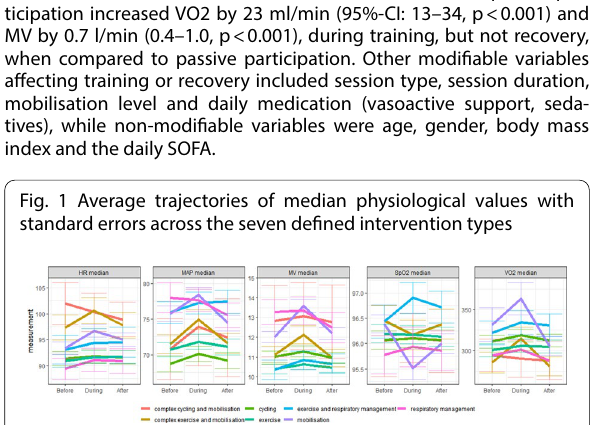
Conclusion. Overall, early physiotherapy does not significantly affect physiological parameters, though variation is high, and clinically rel- evant changes occur in individual patients during training and recov- ery. Physiological parameters should therefore be closely monitored and rehabilitation interventions individually tailored. The identified explanatory variables guide clinicians’ decision-making in delivering the optimal type, intensity and duration by enabling clinicians to pro- spectively estimate the cardiorespiratory response. Reference(s)